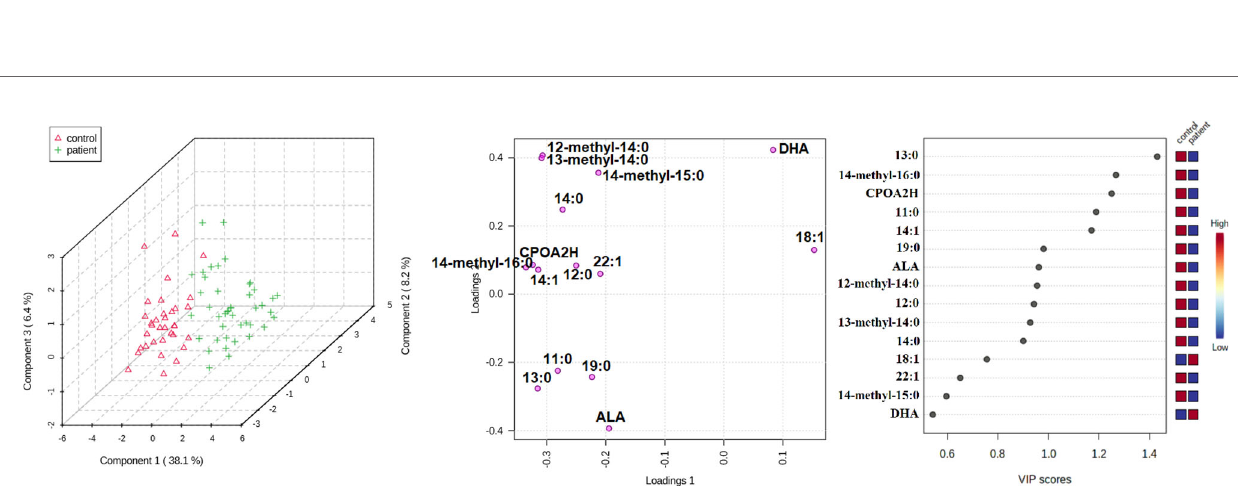
FIGURE 4 | Partial least squares regression (PLS-DA) model, biplot and VIP score for comparison of selected FA in serum of CRC patients and healthy